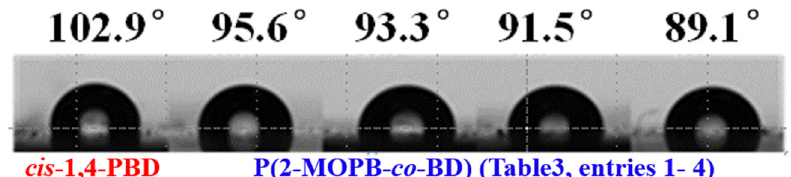
Figure 6. Contact angle characteristic of poly(2-MOPB- co -BD).